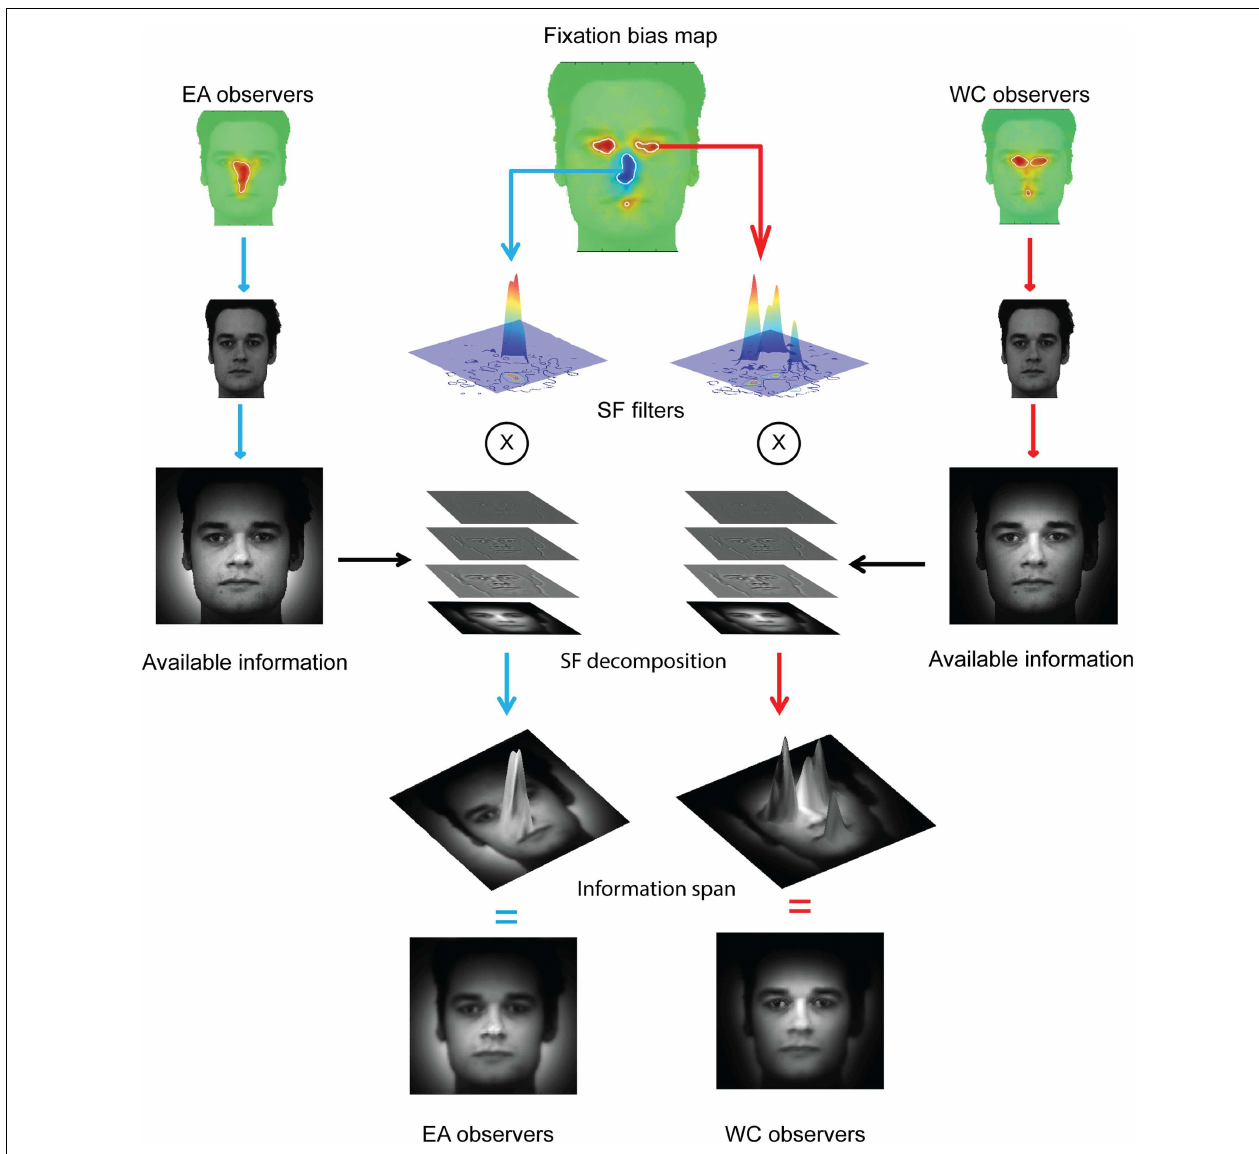
convoluted on the cultural fixation biases extracted from the differential fixation map (see Figure 2 ). See Figure 5 for a fine-grained illustration of the information